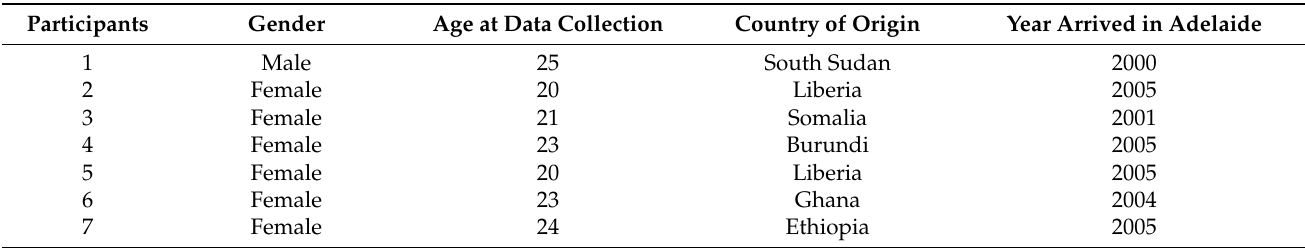
Table 4. Characteristics of focus group youth